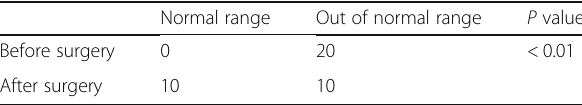
Table 2 Distribution of patients undergoing rhinoplasty in terms of nasal tip projection before and after surgery Normal range Out of normal range P value